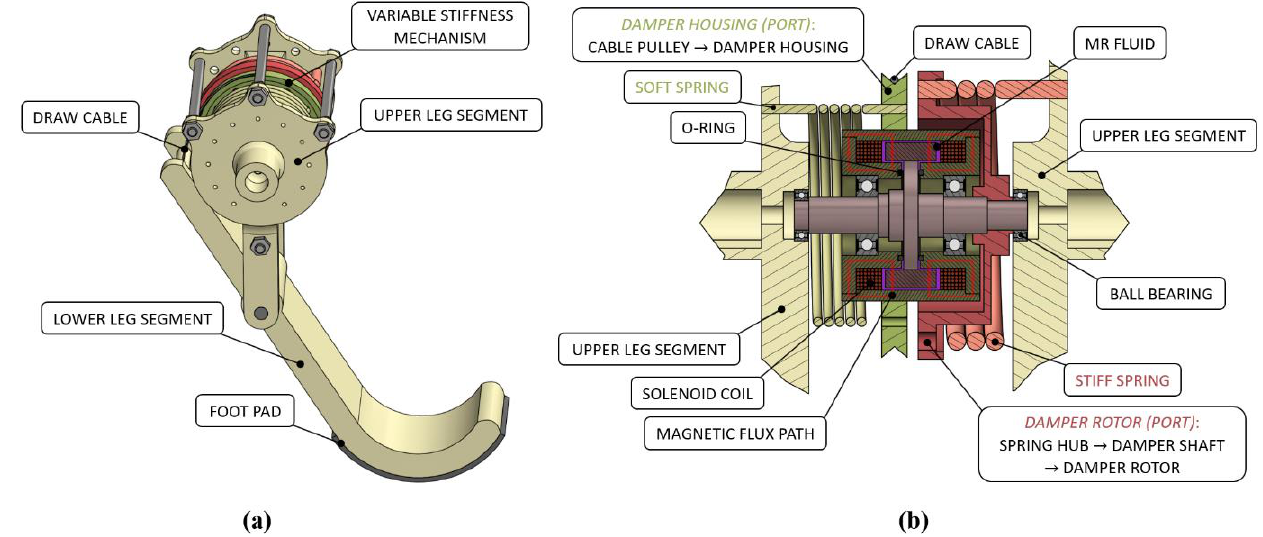
Figure 1. CAD model of ( a ) MRVSAL, and ( b ) the contained variable stiffness mechanism.